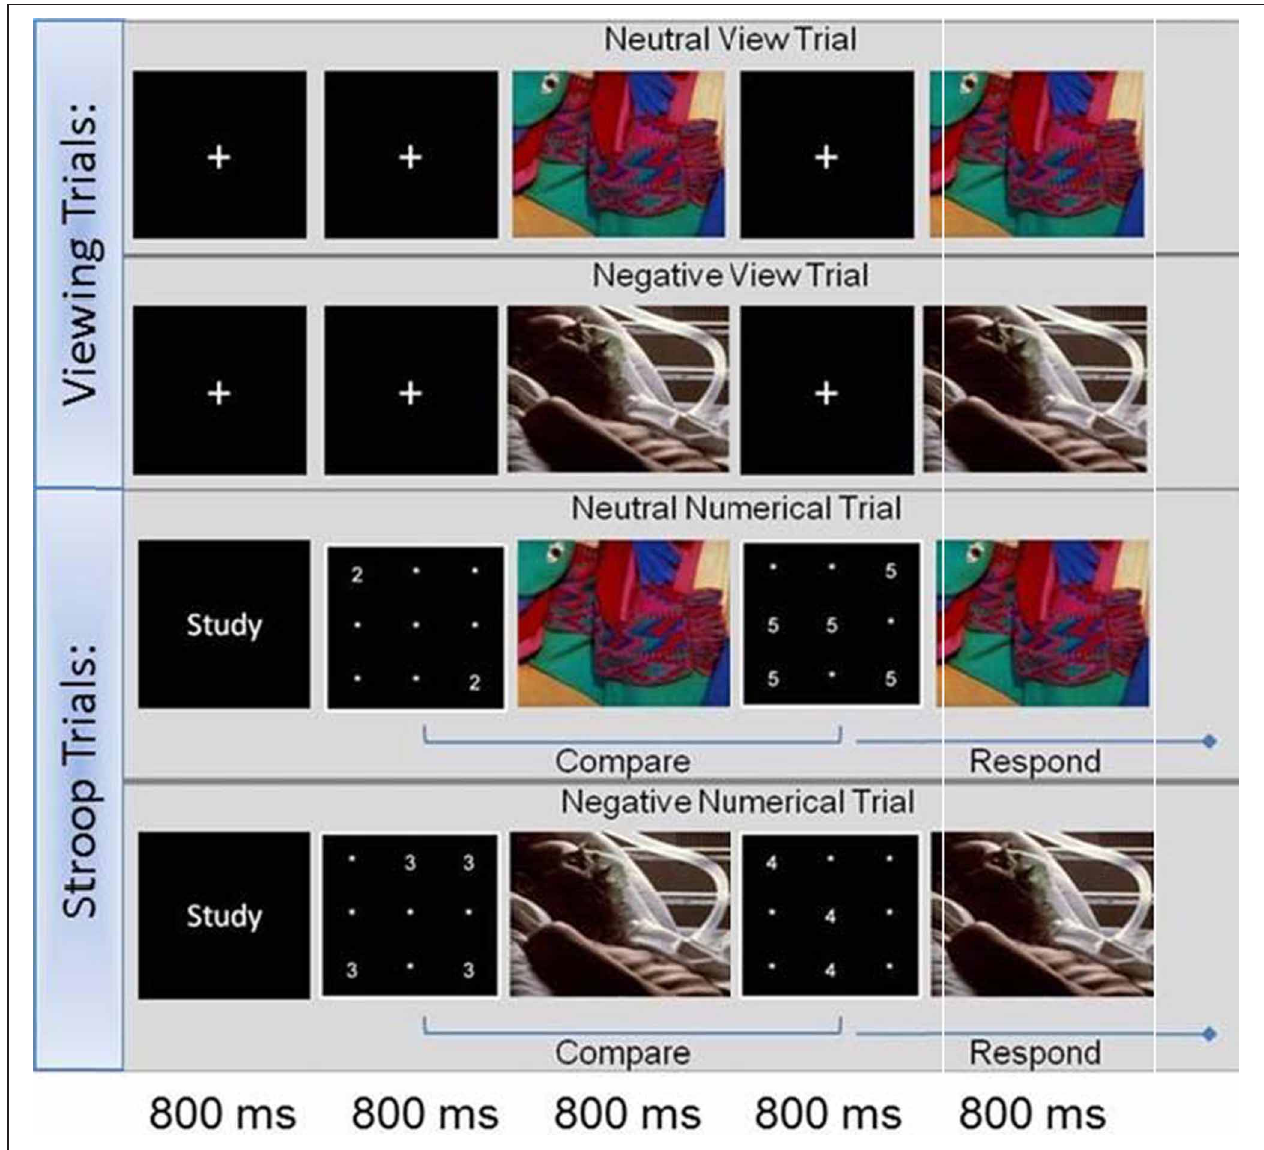
FIGURE 1 | Affective Stroop